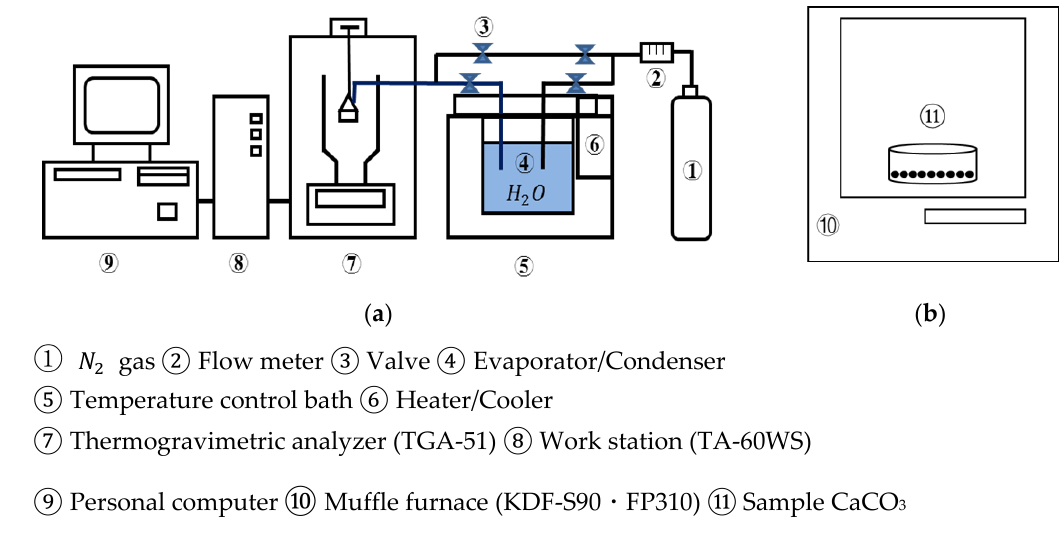
Figure 3. Schematic diagram of experimental unit. ( a ) TGA-51 ( b ) muffle furnace . ① Ofunato and Kawara limestone samples of 10 g/100 g (710–1000 µmφ) are heated at a rate of 10 K/min to 1223 K, 1273 K, 1373 K, 1473 K, 1573 K and kept at that temperature for different periods in